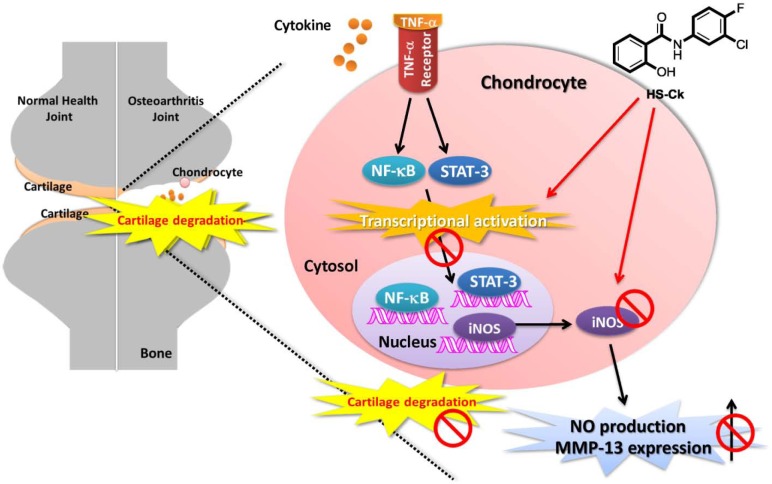
Proposed mechanism of action for the chondroprotective effects of HS-Ck on TNF-α-induced cartilage degradation in porcine chondrocytes includes the suppressive effects on activation of NF-κB and STAT-3 transcriptional factors, iNOS expression, NO production, and MMP-13 activities.